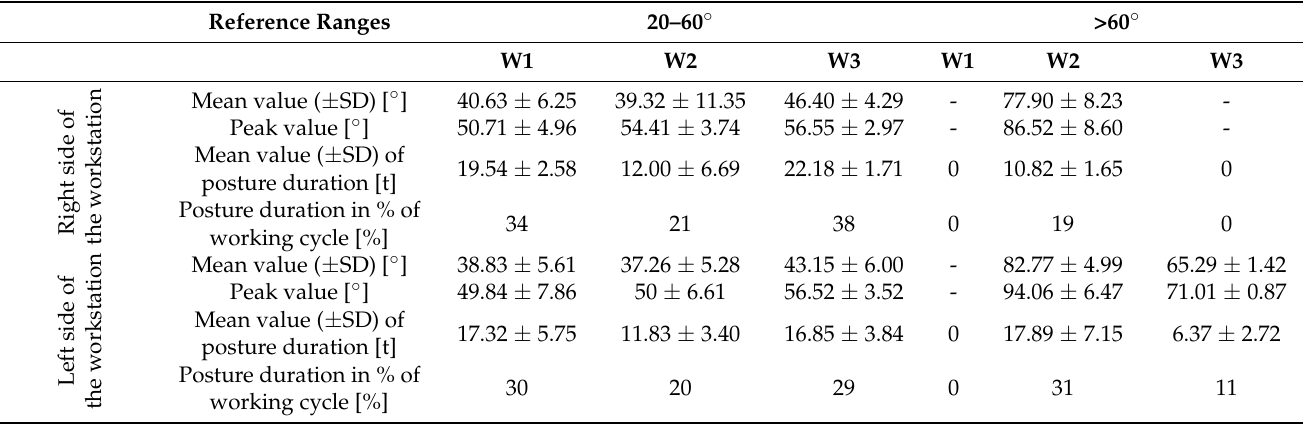
Table 2. Trunk flexion forward static posture data analysis: mean and peak flexion forward angle and duration